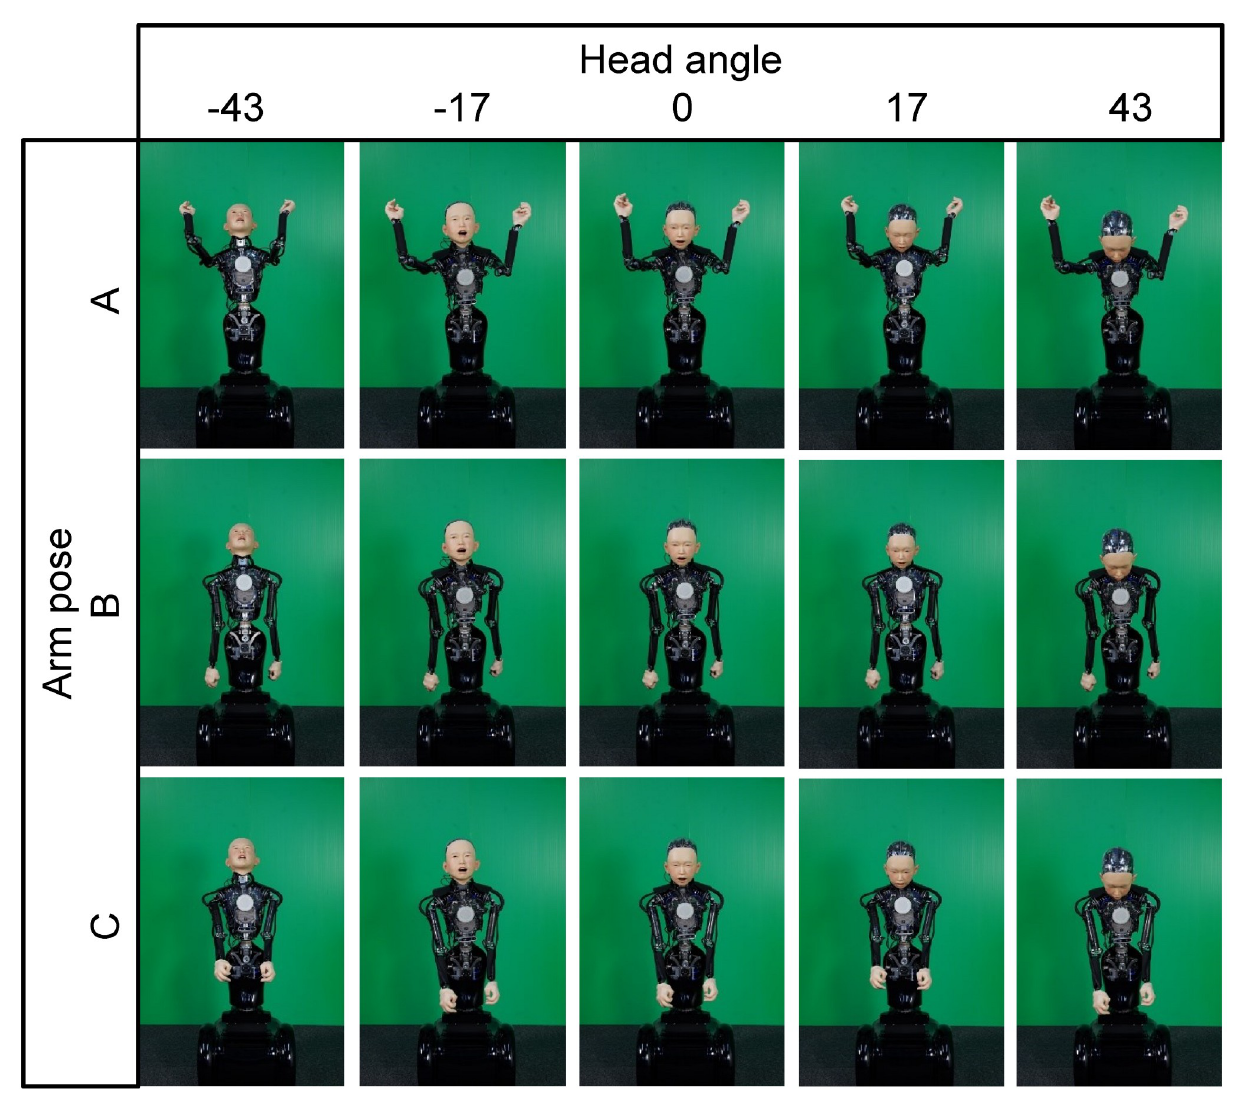
Fig 4. 15 postures from the front